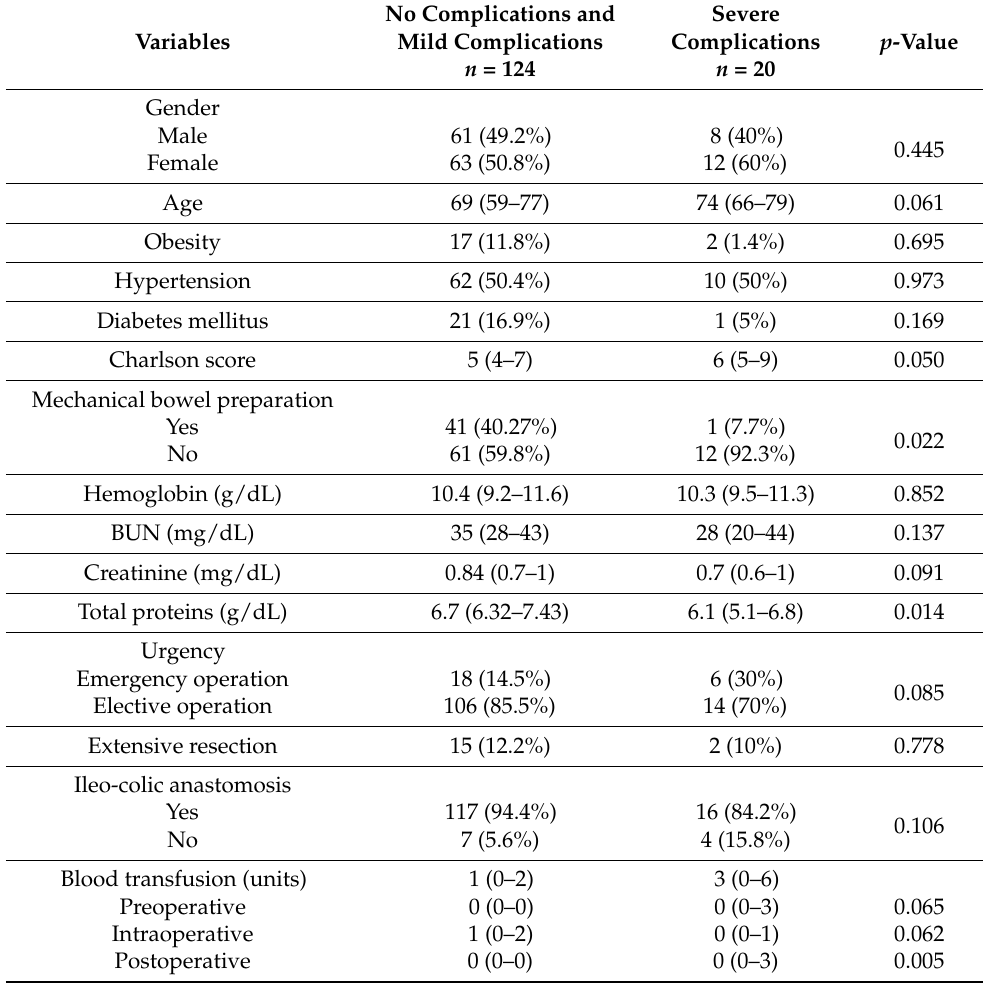
Table 2. Univariate analysis of prognostic factors for postoperative severe